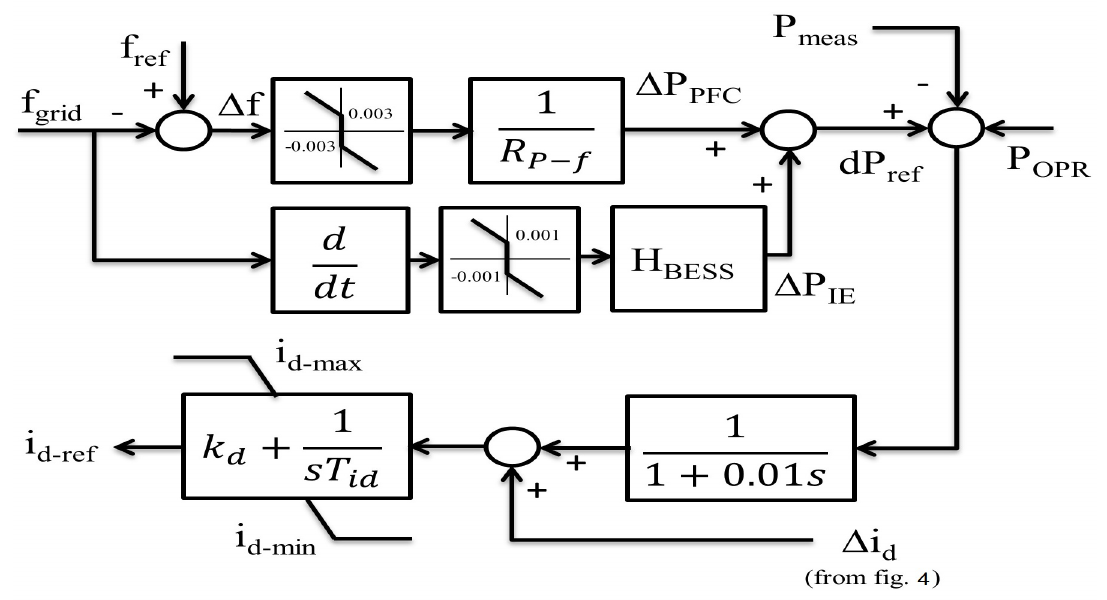
Figure 2. Block diagram of BESS for the inertia emulation (IE)- and primary frequency control (PFC)-regulated frequency